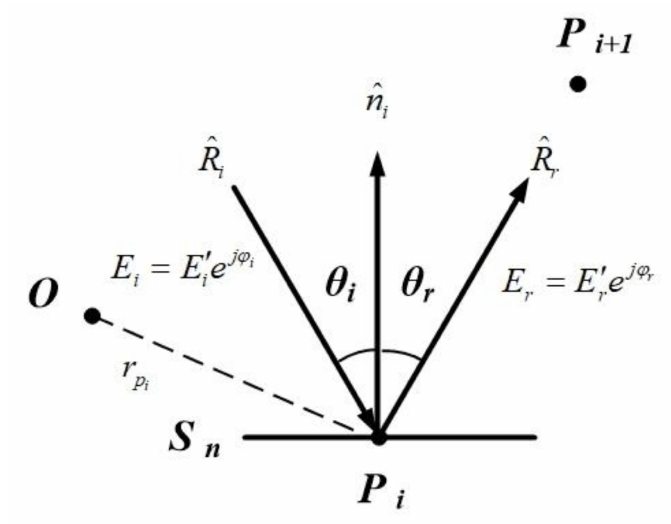
Figure 5. Sketch map of the i -th reflection on the facet S n